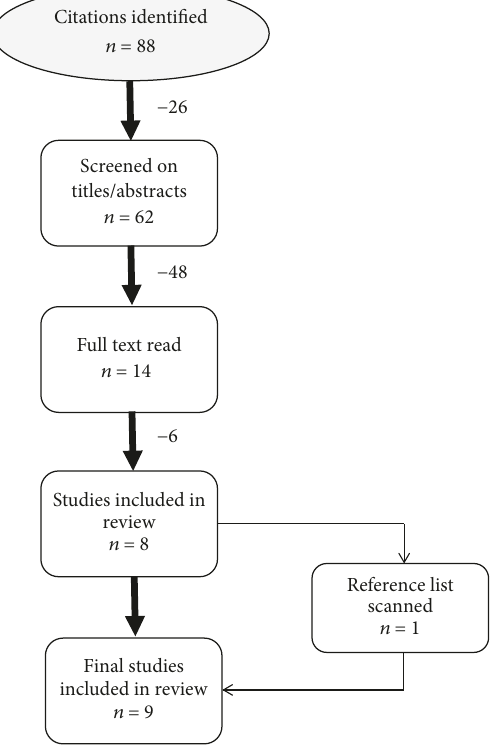
Figure 1: Chart of literature